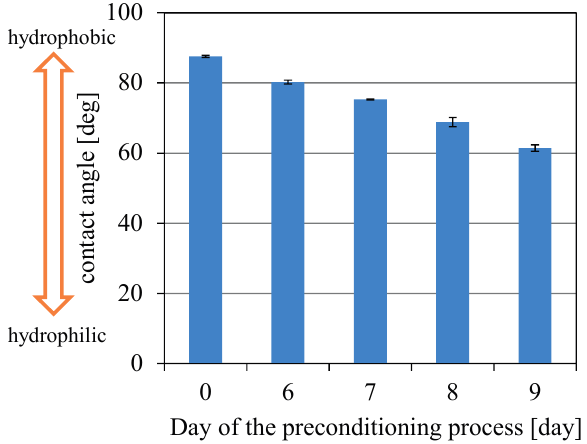
Figure 3. The contact angle of a water droplet with the lipid/polymer